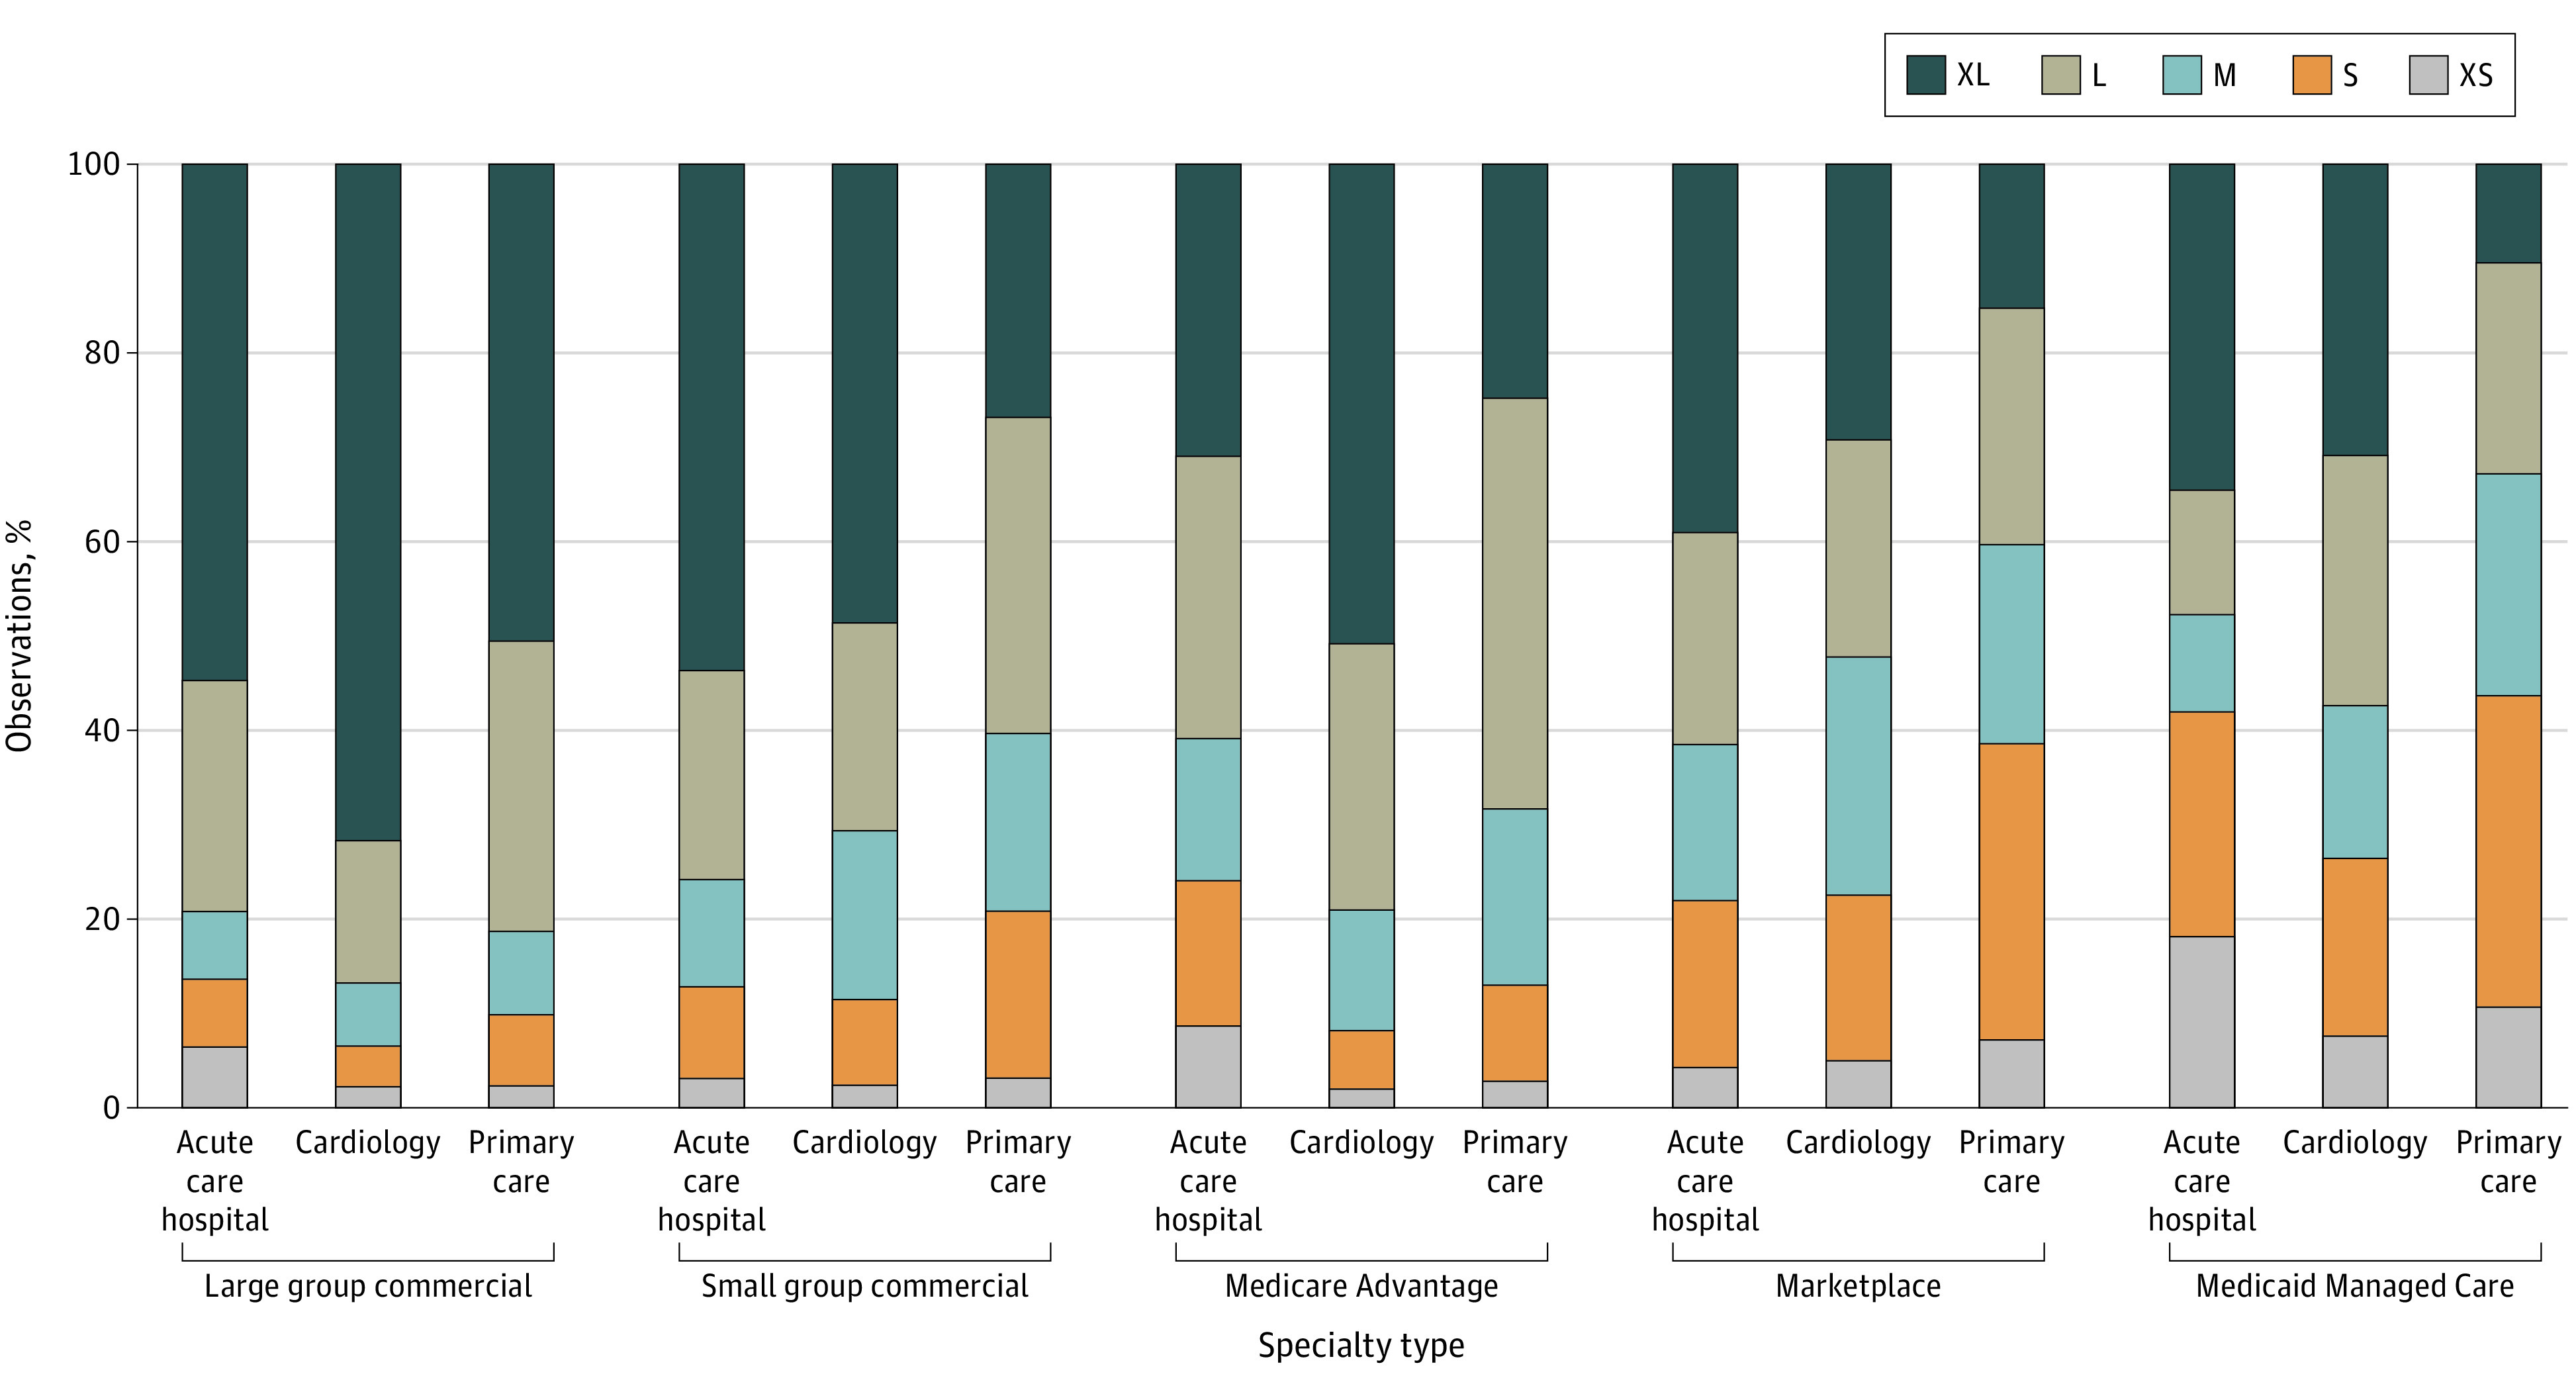
Primary Care Hospital and Physician Network BreadthThe figure shows the percentage of observations in each network breadth category by specialty or type and insurance type. Network breadth was defined as the percentage of hospitals or physicians within a 60-minute drive that were in-network for each zip code–specialty type–insurance type–network combination. In total there were 1 248 138 such observations for primary care networks, 1 173 486 for cardiology networks, and 1 446 413 for hospital networks. The continuous network breadth measure was then categorized based on the following sizes: extra small (XS; <10% breadth); small (S; 11%-25%); medium (M; 26%-40%); large (L; 41%-60%); and extra large (XL; >60%).